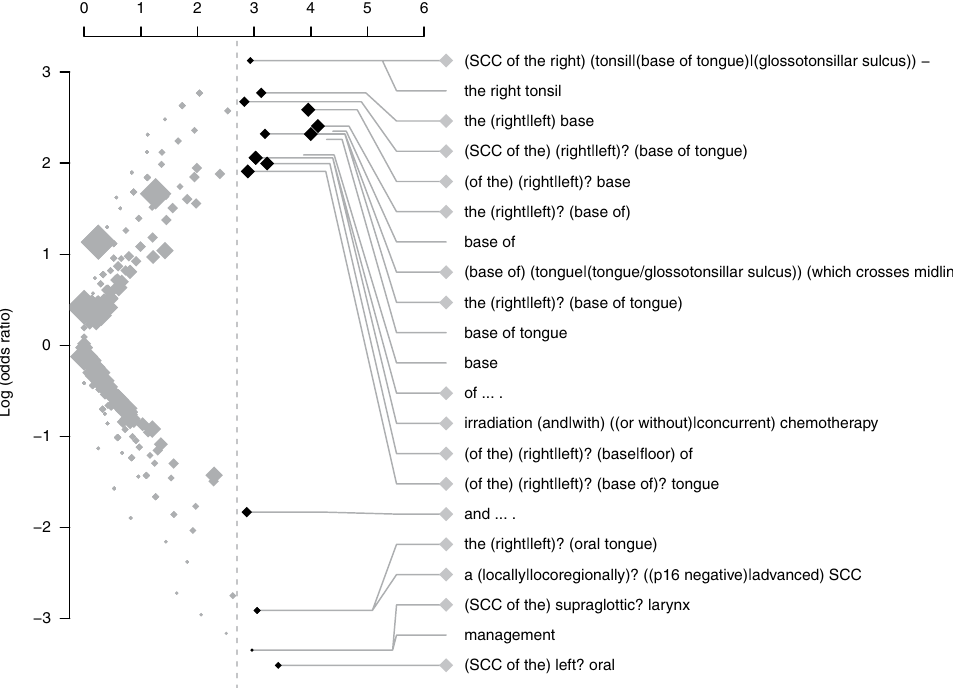
Figure 4. Volcano plot showing the ranking text features associated with HPV status discovered from the HNSCC MDT reports. Note: Labels of patterns with p < 0.002 are shown in this plot. Legend: ◆ : regular expression. ∙: n-gram text fragments. The pattern of regular expression “( A|B )” indicates either A or B would match the string, and “?” indicates an optional element. The size of diamond or circle is proportional to total number of cases mentioning the text patterns in the